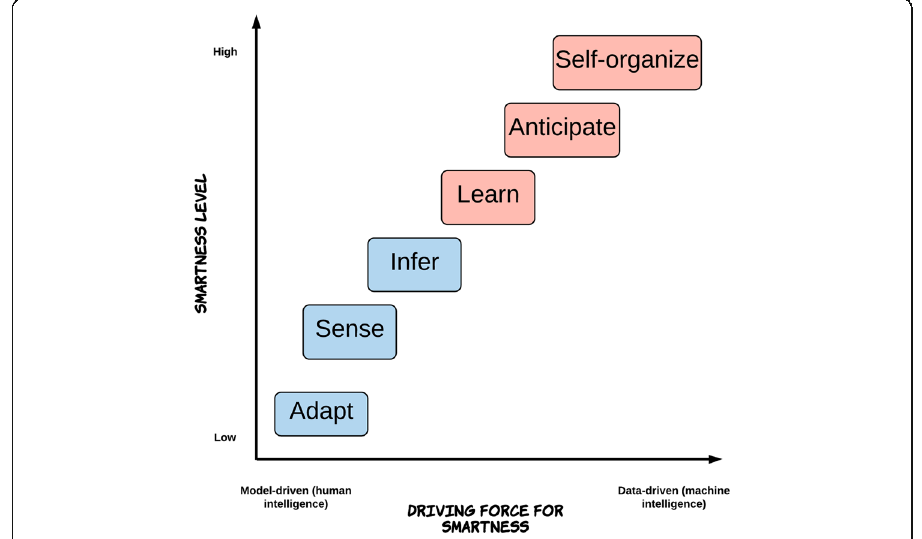
Fig. 8 Driving forces for different smartness levels in SLE (Based on Uskov et al.,